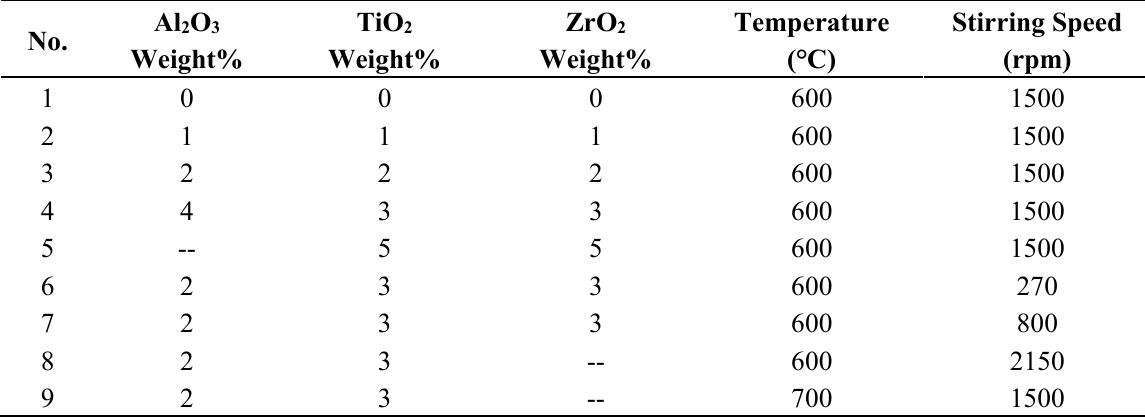
Table 3. Casting conditions used in this